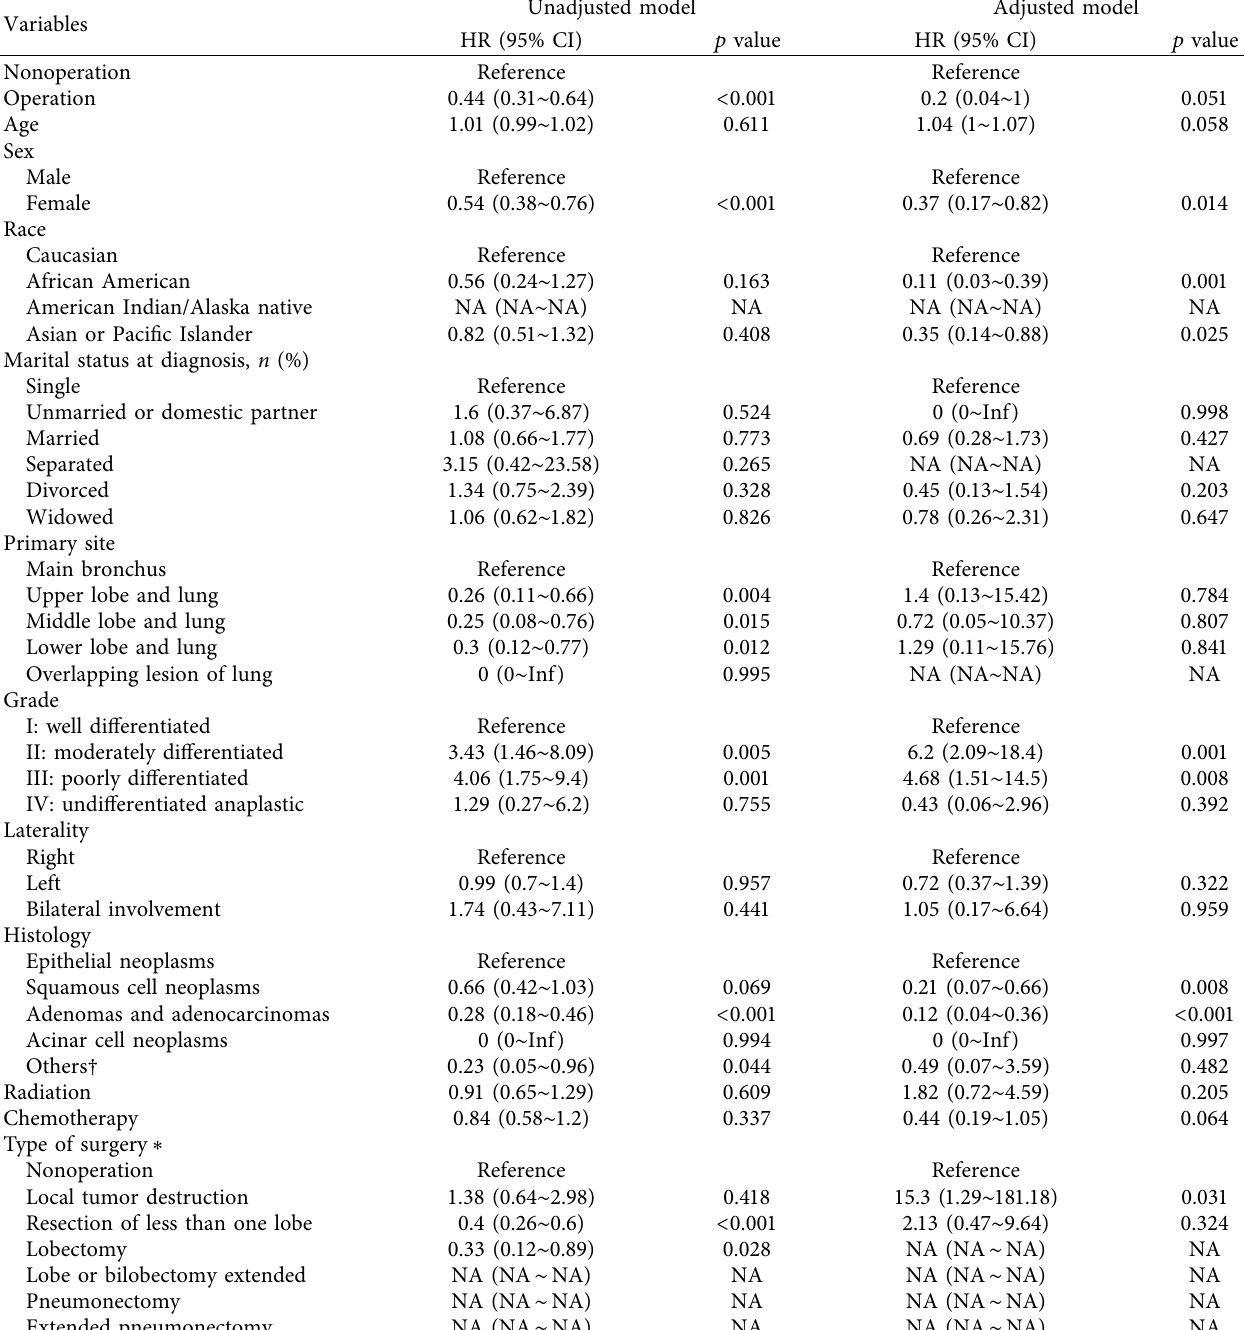
Table 3: Te multivariable Cox proportional hazard regression analyses for stage